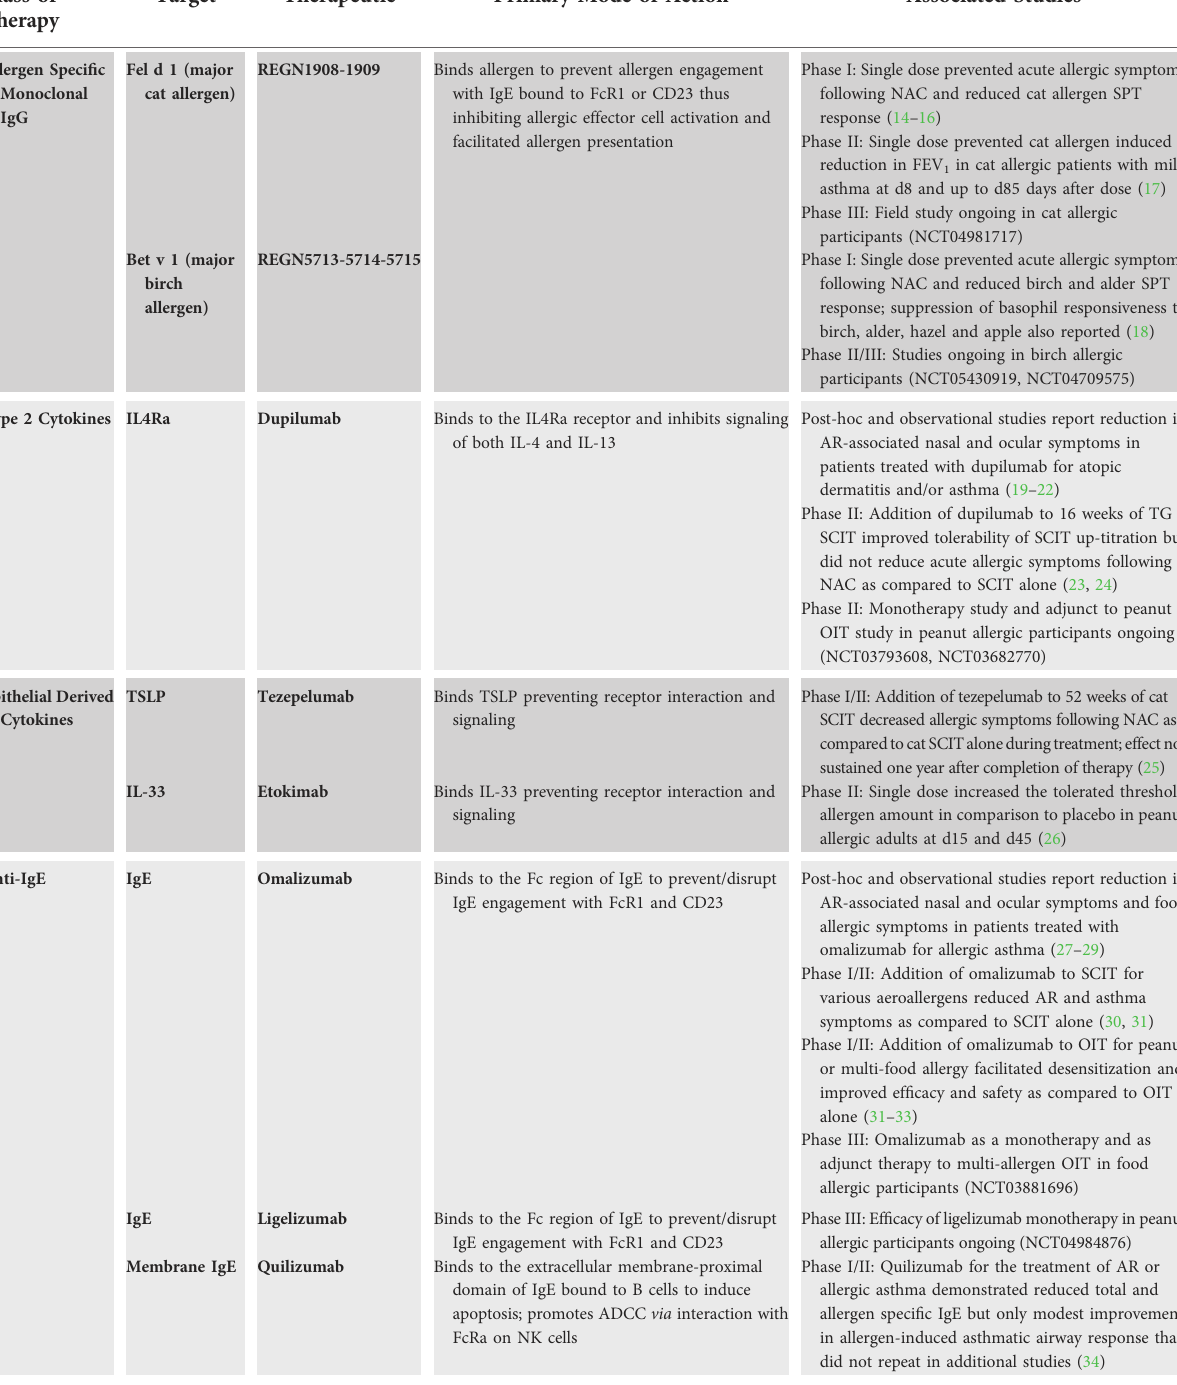
TABLE 1 Biologics evaluated for the treatment of